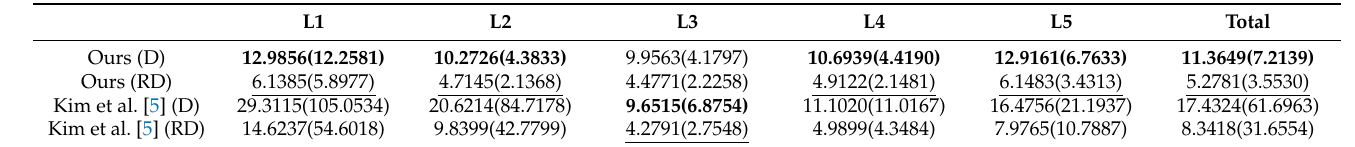
Table 11. Comparison of landmark detection performance between our method and Kim et al. [5]. The lowest value for each column in distance error (D) is marked in bold and underlined in relative distance error (RD).